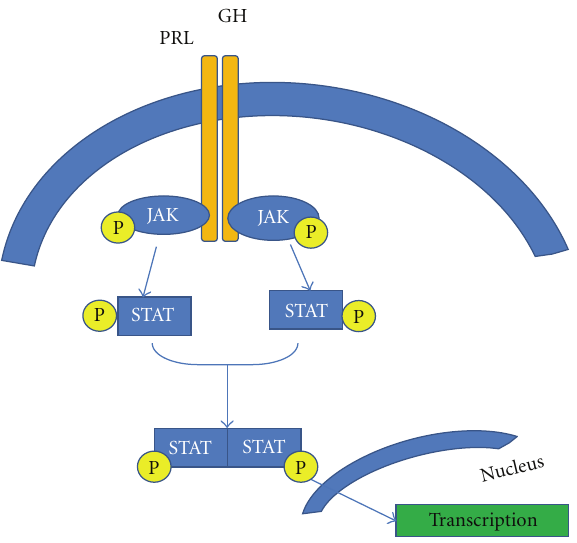
Figure 3: Schematic representation of JAK/STAT signalling. Mech- anisms through prolactin and growth hormone modulate beta-cell proliferation. These hormones via prolactin receptor activate JAK, which is able to phosphorylate STAT. After phosphorylation, two molecules of STAT bind together and translocate into the nuclei where elicit their transcriptional